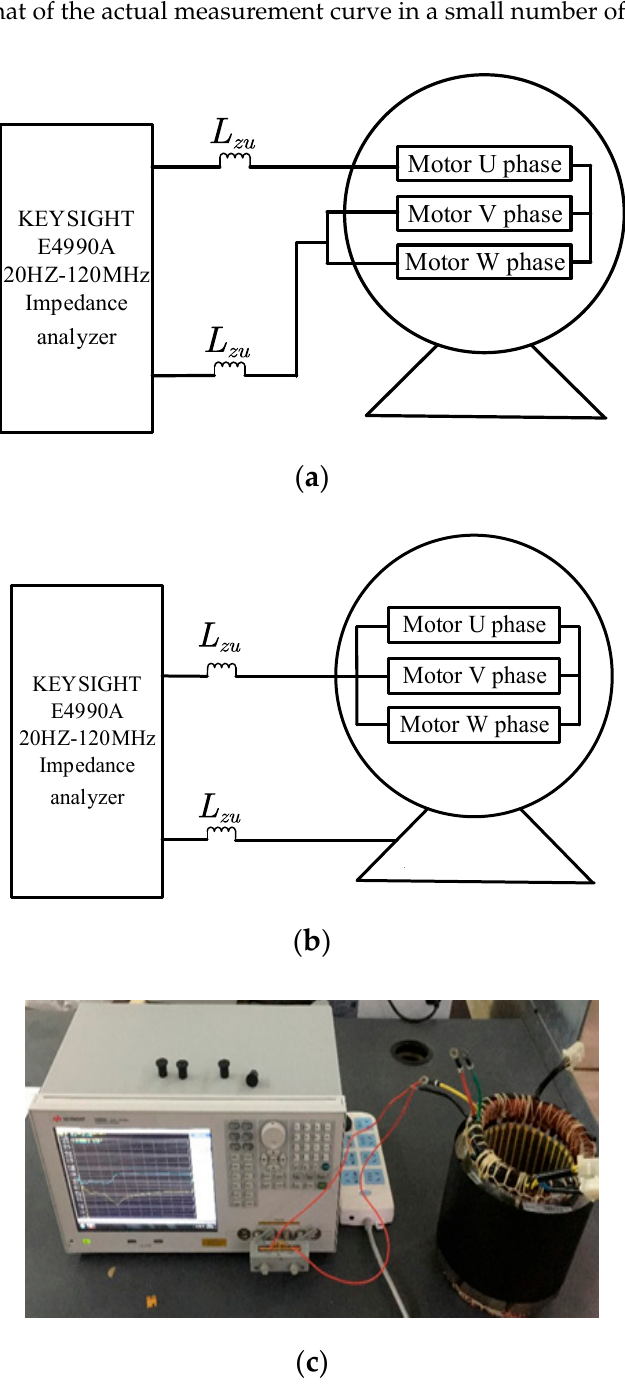
Figure 5. Common mode and differential mode impedance measurement wiring diagram of synchronous machine: ( a ) common mode impedance measurement wiring; ( b ) differential mode impedance measurement wiring; and ( c ) measurement site map.